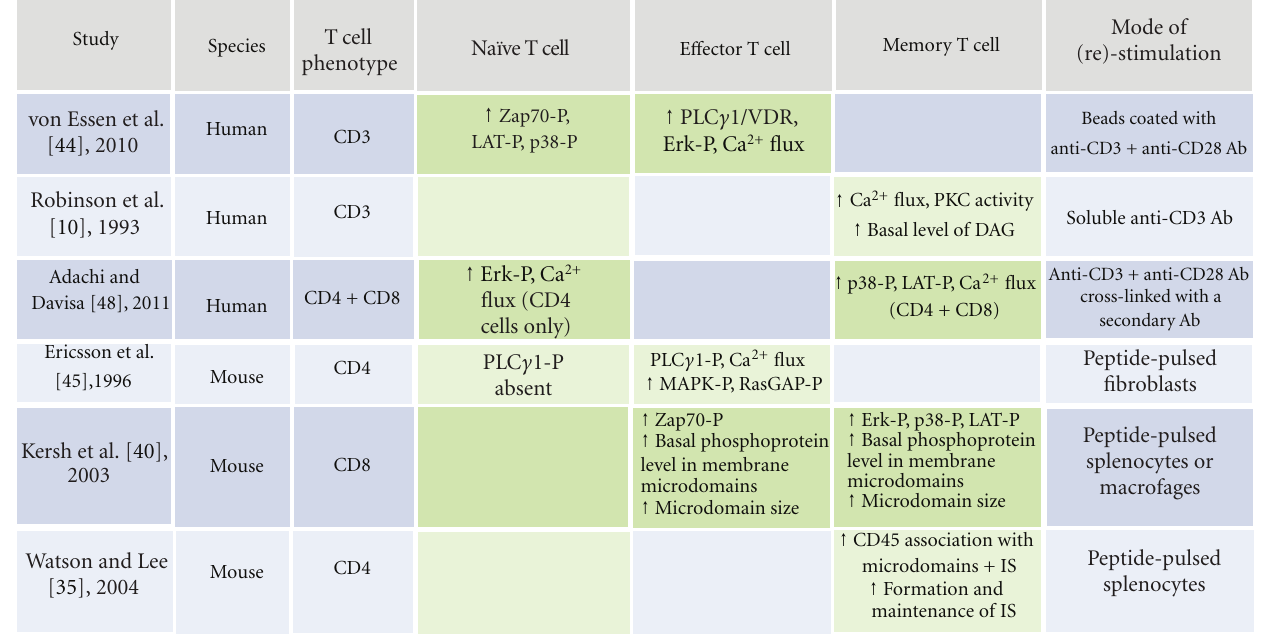
Table 2: Studies describing di ff erences in the TCR signaling machinery of na¨ıve and primed T cells. Green cells indicate the investigated T cell populations. Arrows indicate an increase. P denotes phosphorylation of the given enzyme following TCR